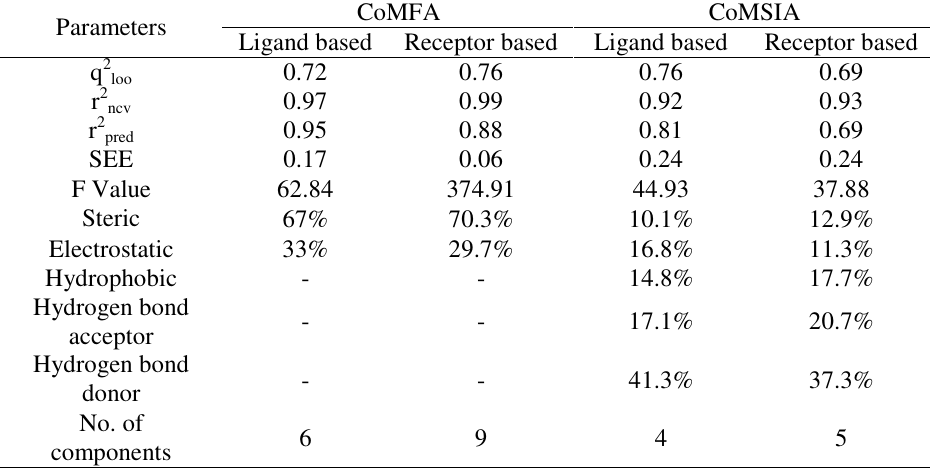
Table 2. Statistical summary of PLS